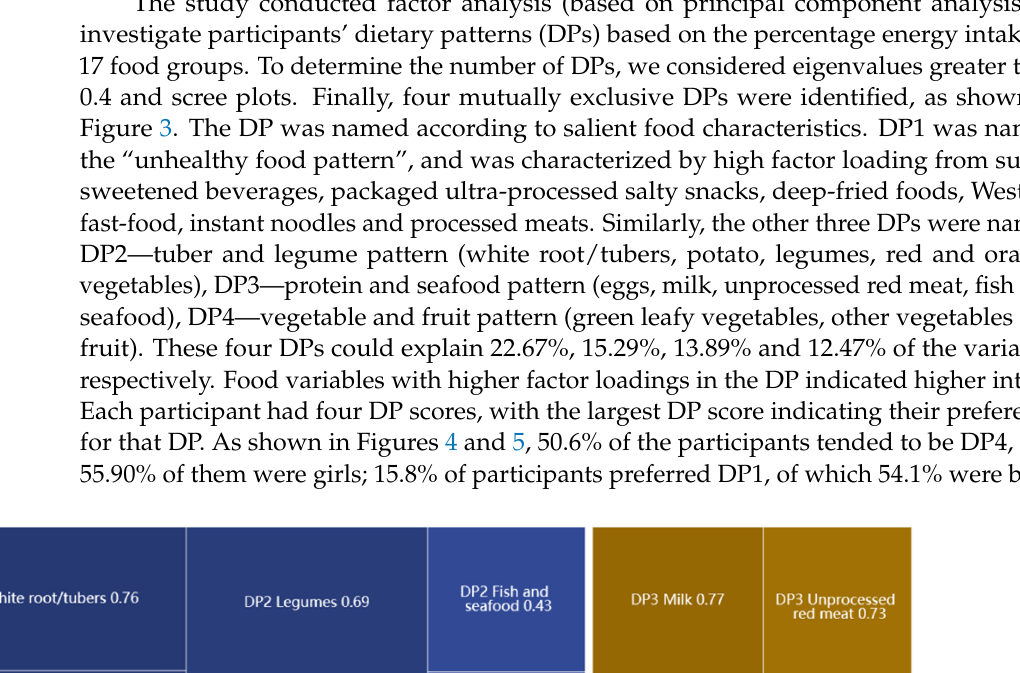
Figure 4. Percentage of each dietary pattern. Figure 5. Number and proportion of boys and girls in each dietary pattern.